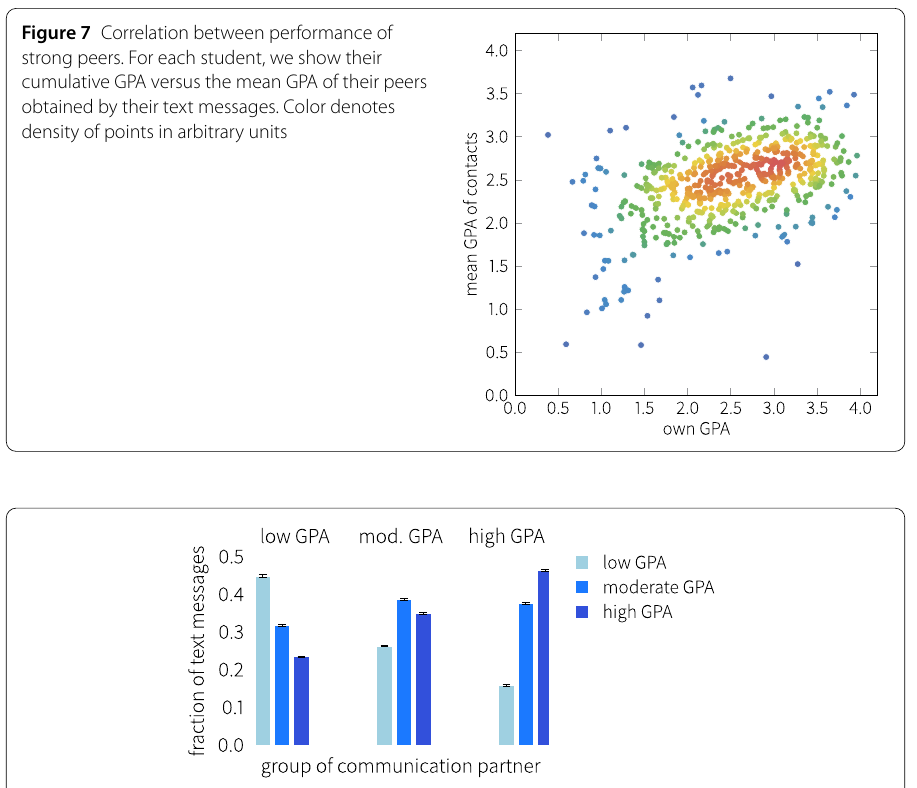
Figure 7 Correlation between performance of strong peers. For each student, we show their cumulative GPA versus the mean GPA of their peers obtained by their text messages. Color denotes density of points in arbitrary